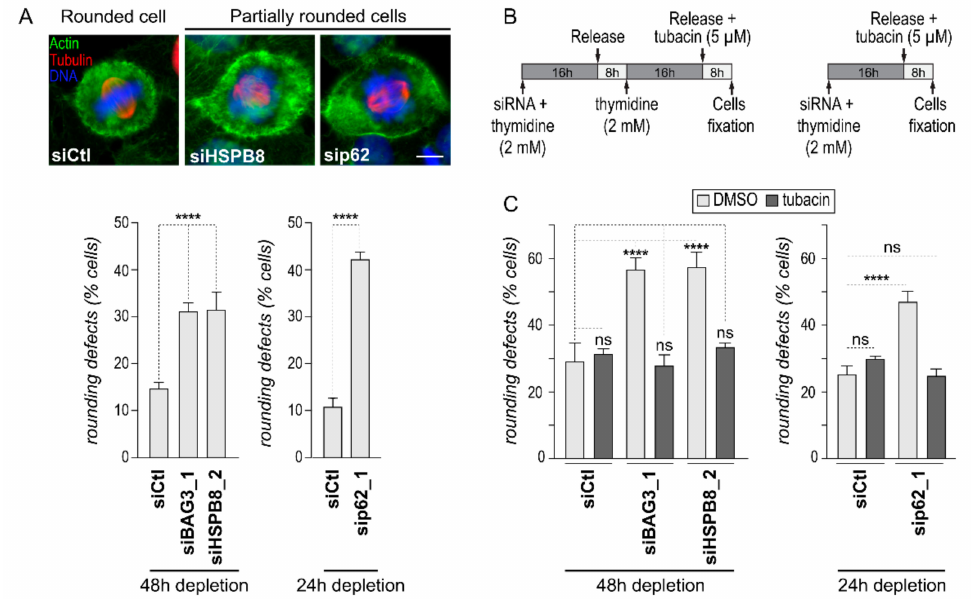
Figure 1. Downregulation of HDAC6 activity can normalize mitotic cell rounding in cells depleted of BAG3, HSPB8 or p63/SQSTM1. ( A ) Epifluorescence images of HeLa-H2B-RFP cells showing a typical mitotic morphology (siCtl) as compared to cell rounding defects (sip62, siHSPB8). The graph shows quantification of the percentages of mitotic cells treated with the indicated siRNAs that displayed rounding defects (flat or partially rounded cells); means ± SEM ( n = 609 to 817 cells from N = 3 experiments). Scale bar: 10 µ m. ( B ) Schematics of the protocols; phenotypes were quantified on fixed cells 24 h or 48 h after siRNA transfection, as indicated. ( C ) The graphs depict mitotic cell rounding defects (flat or partially rounded cells); means ± SEM ( n = 591 to 633 cells from 3 experiments). Statistical analyses were performed by the chi-square test; ****, p < 0.0001; ns,